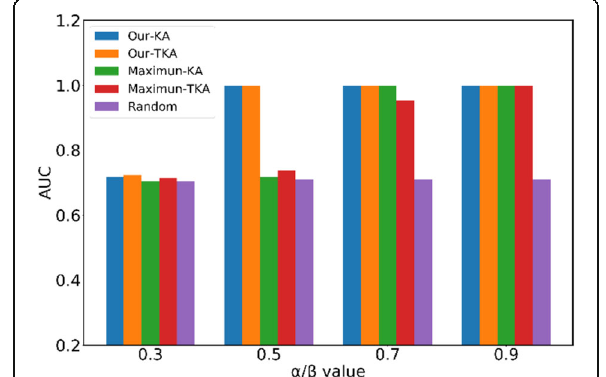
Fig. 5 The different parameters are employed in the weighted similarity function WCN, and λ = 0.9 to obtain AUC values